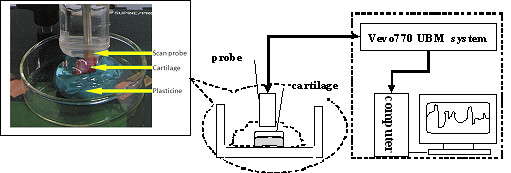
Schematic of the ultrasound experimental set-up using Vevo 770 UBM system. Samples were fixed at the bottom of the container by plasticine and the cartilage surface was covered with ultrasound gel.